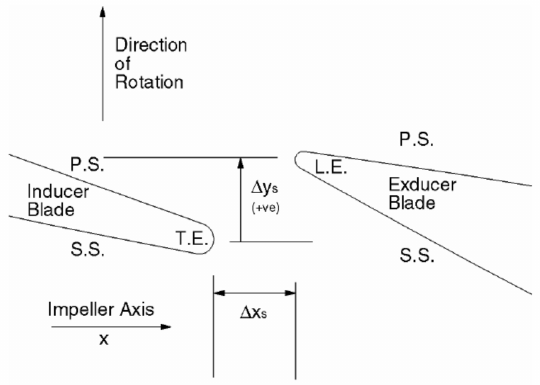
Figure 5. Schematic representation of clock ( ∆ y s ) and axial displacement ( ∆ x s